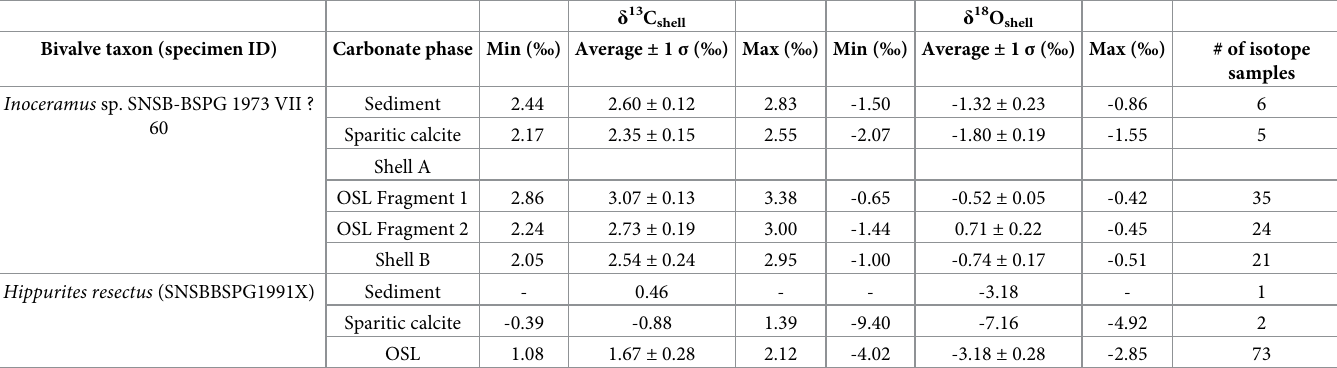
Table 1. Stable oxygen and carbon isotope values of the different carbonate phases analyzed in this study.